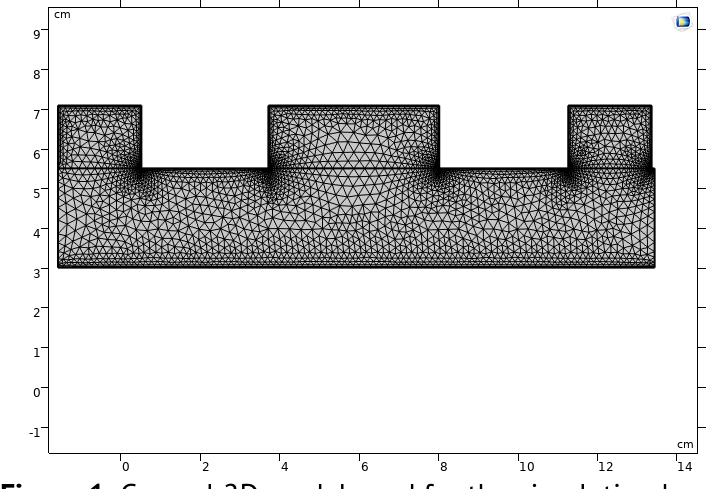
Figure 1 . Comsol 2D model used for the simulation has been shown along with the